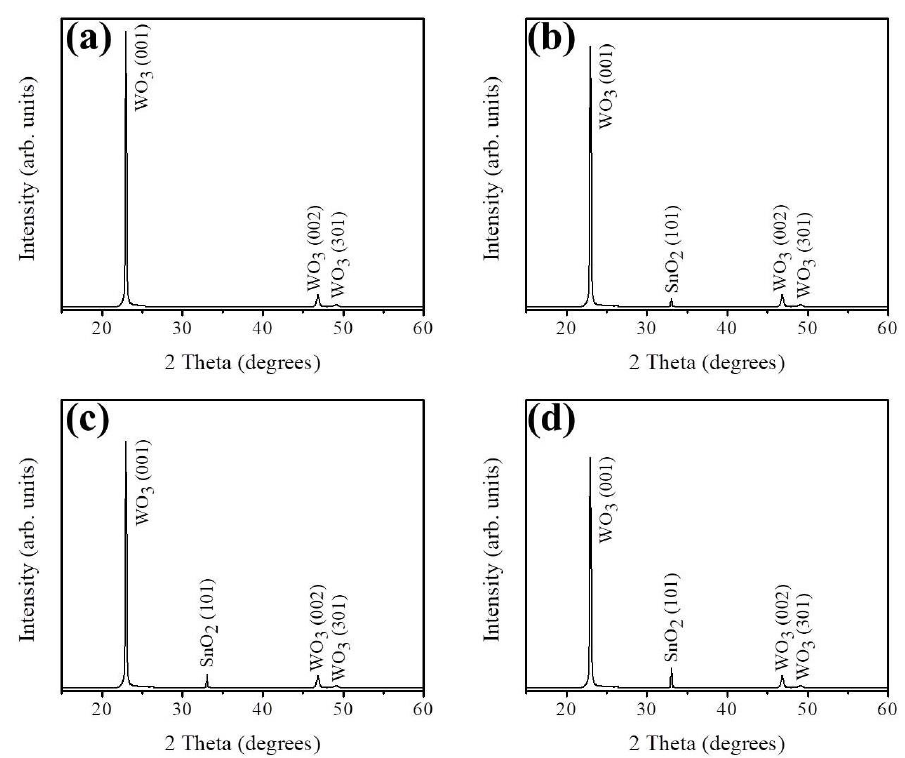
Figure 1. X-ray diffraction (XRD) patterns of various nanorods: ( a ) WO 3 , ( b ) WS-1, ( c ) WS-2, and ( d ) WS-3.